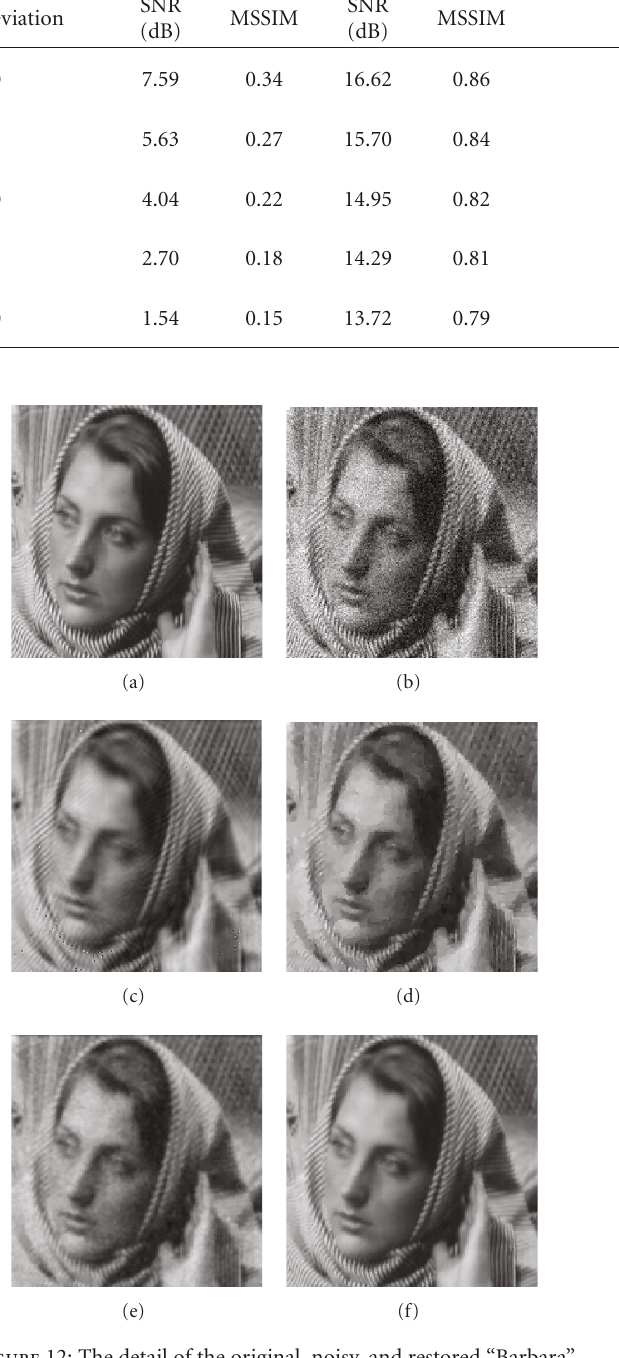
Figure 12: The detail of the original, noisy, and restored “Barbara” images: (a) the original image; (b) the noisy image (SNR = 8.73, MSSIM = 0.48); (c) the restored image by the curvelet shrinkage method (SNR = 12.05, MSSIM = 0.77); (d) the restored image by using the “TV” model (SNR = 12.74, MSSIM = 0.77); (e) the restored image by using the “TVGF” model (SNR = 11.39, MSSIM = 0.72); (f) the restored image by using our proposed model (SNR = 13.15, MSSIM = 0.81).